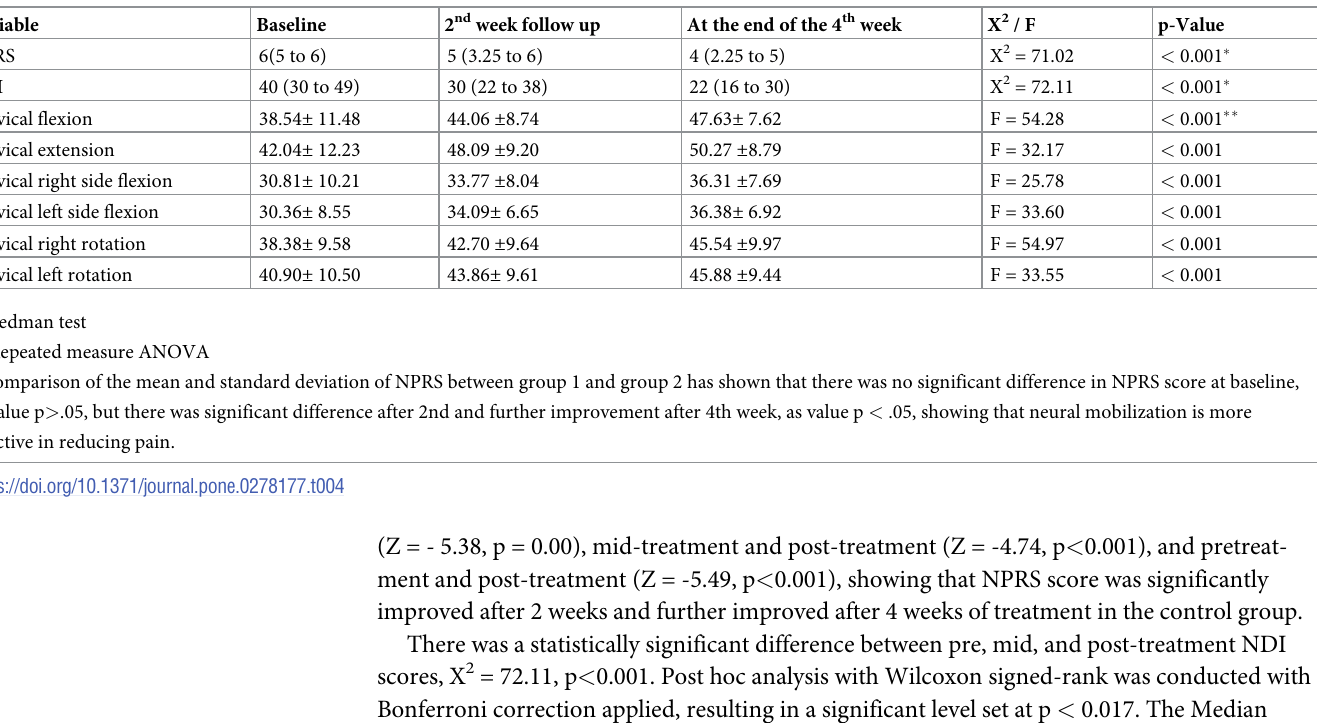
Table 4. Comparison of pain (NPRS), disability (NDI), and cervical mobility (ROM) within the control group.